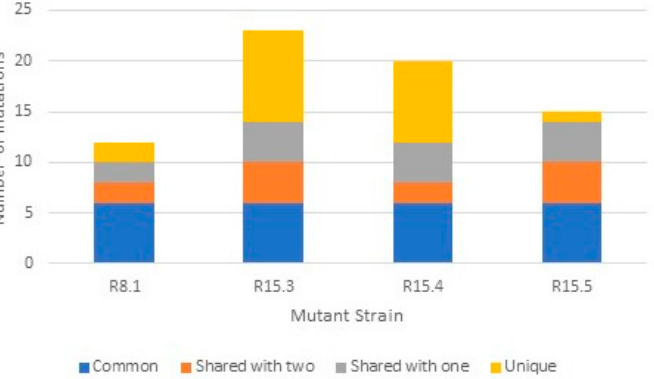
Figure 6. Number of mutations (SNPs or INDELs) observed in each mutant strain in comparison with the parental strain and their distribution in comparison with the other mutants.